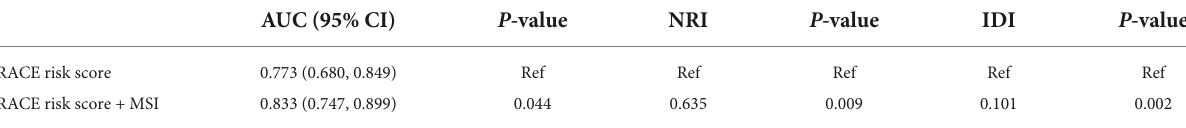
TABLE 4 Model performance after the addition of MSI to the GRACE risk